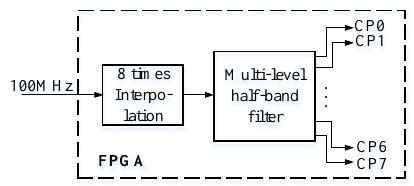
Figure 2. Diagram of fine delay module.